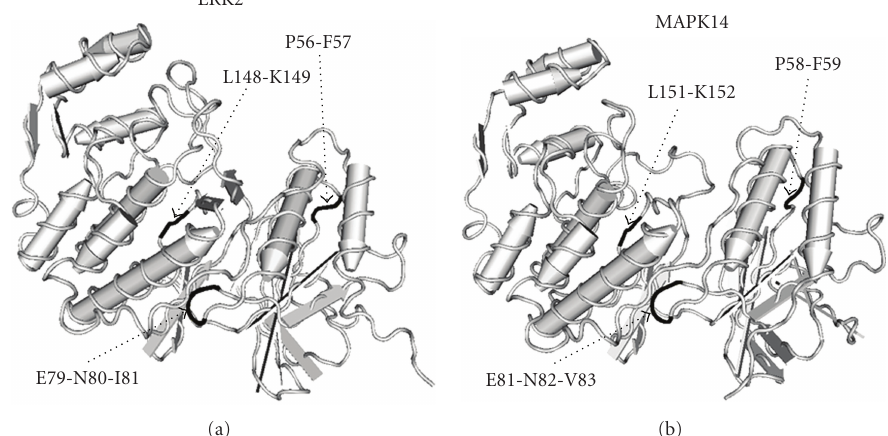
Figure 3: Three-dimensional structures of ERK2 (a) and MAPK14 (b) human proteins from PDB database (PDB files 2E14 and 1A9U, resp.). Critical residues and their positions within the two proteins are